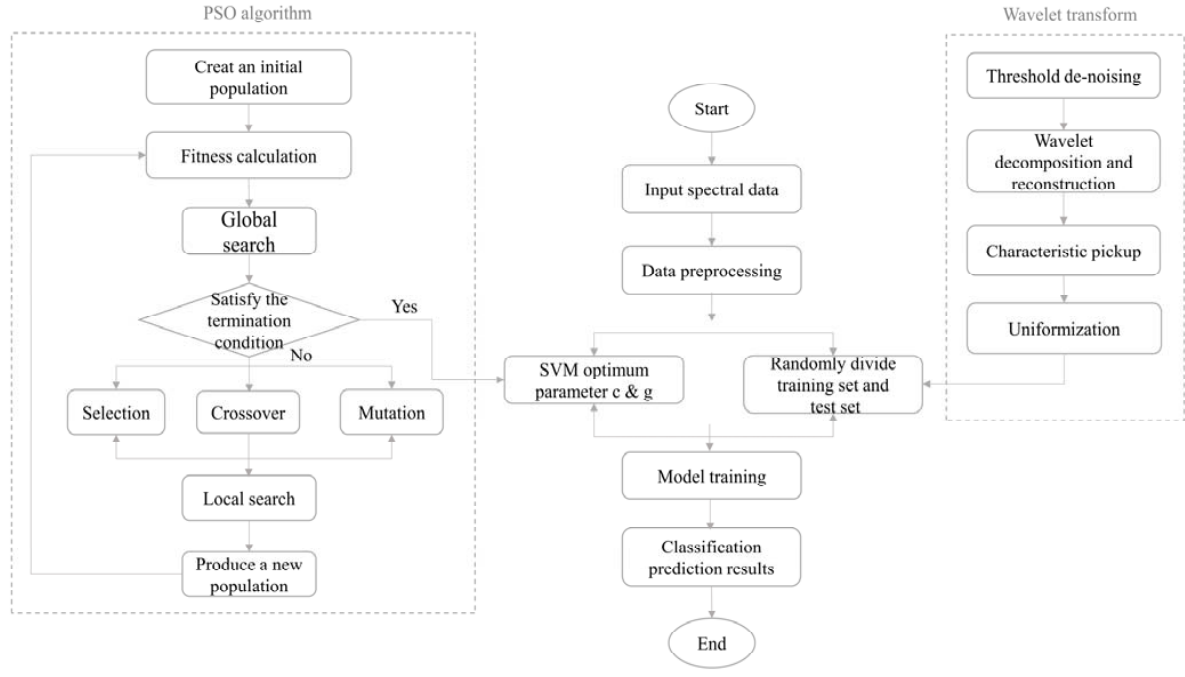
Figure 3. Flowchart of support vector calibration